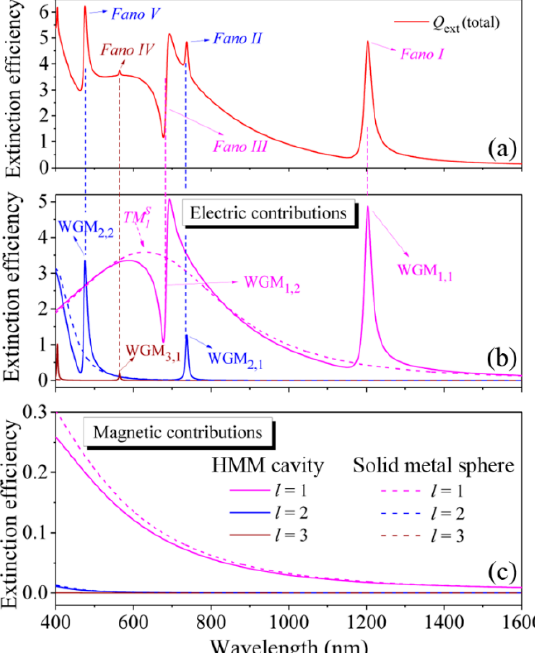
Figure 2. ( a ) The calculated total extinction efficiency spectrum of the HMM cavity with struc- tural/material parameters of r = 20 nm, s = 20 nm, d = 15 nm and n = 1.4. The total extinction efficiency spectra of a spherical HMM cavity (solid lines) and a solid Ag nanosphere with radius of 110 nm (dashed lines) are decomposed into separate contributions of the electric ( a l ) ( b ) and magnetic ( b l ) Mie modes, ( c ) with the angular mode number of l = 1,2,3.